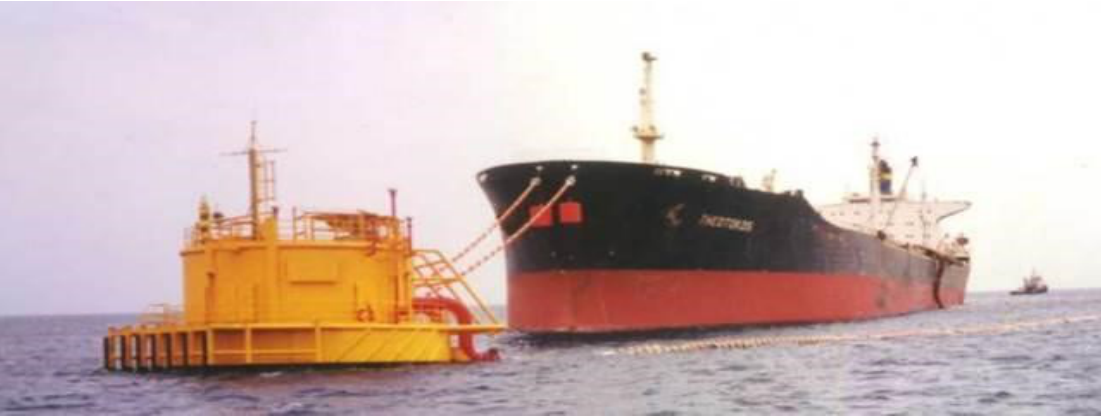
Figure 2. CALM Buoy with an FSO offloading tanker off the shore of Sudan (Courtesy of